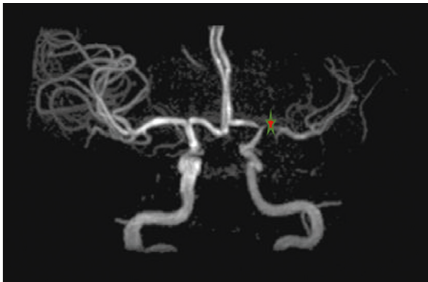
Figure 1: Our patient’s magnetic resonance angiogram of the brain. The location of the red star shows the stenoses of the origin of the left anterior cerebral artery (A1 segment) and origin of the left middle cerebral artery (M1 segment), with associated thrombosis of the origin of the left middle cerebral